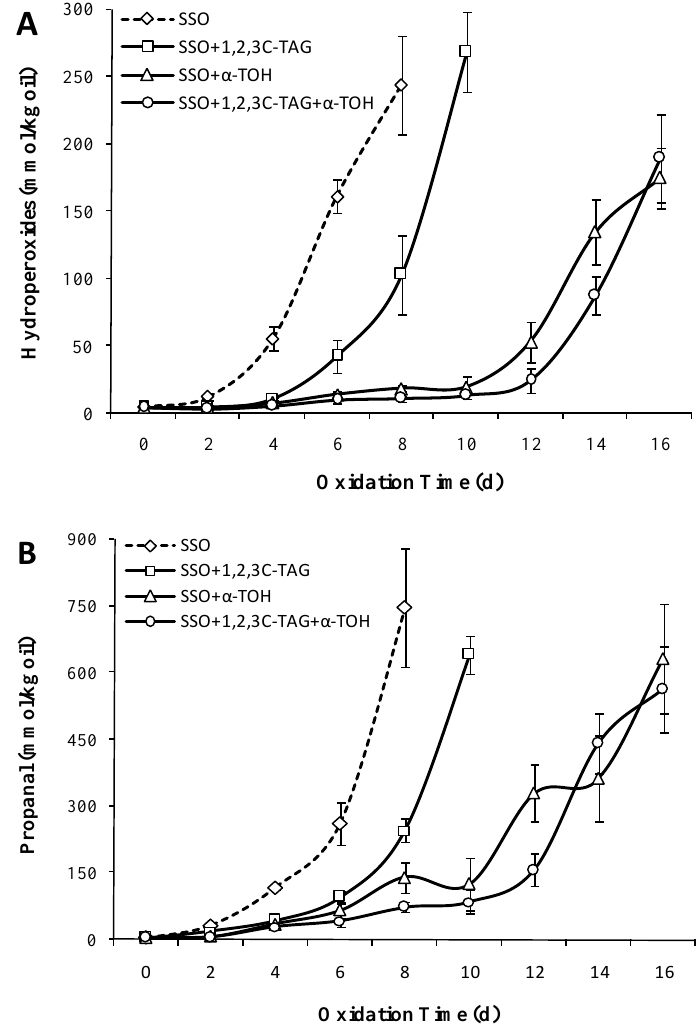
Figure 9. Effect of 1,2,3C-TAG structured lipids on the content of POV ( A ) and propanal ( B ) of stripped soybean oil with and without α-tocopherol (50 °C). soybean oil with and without α -tocopherol (50 ◦